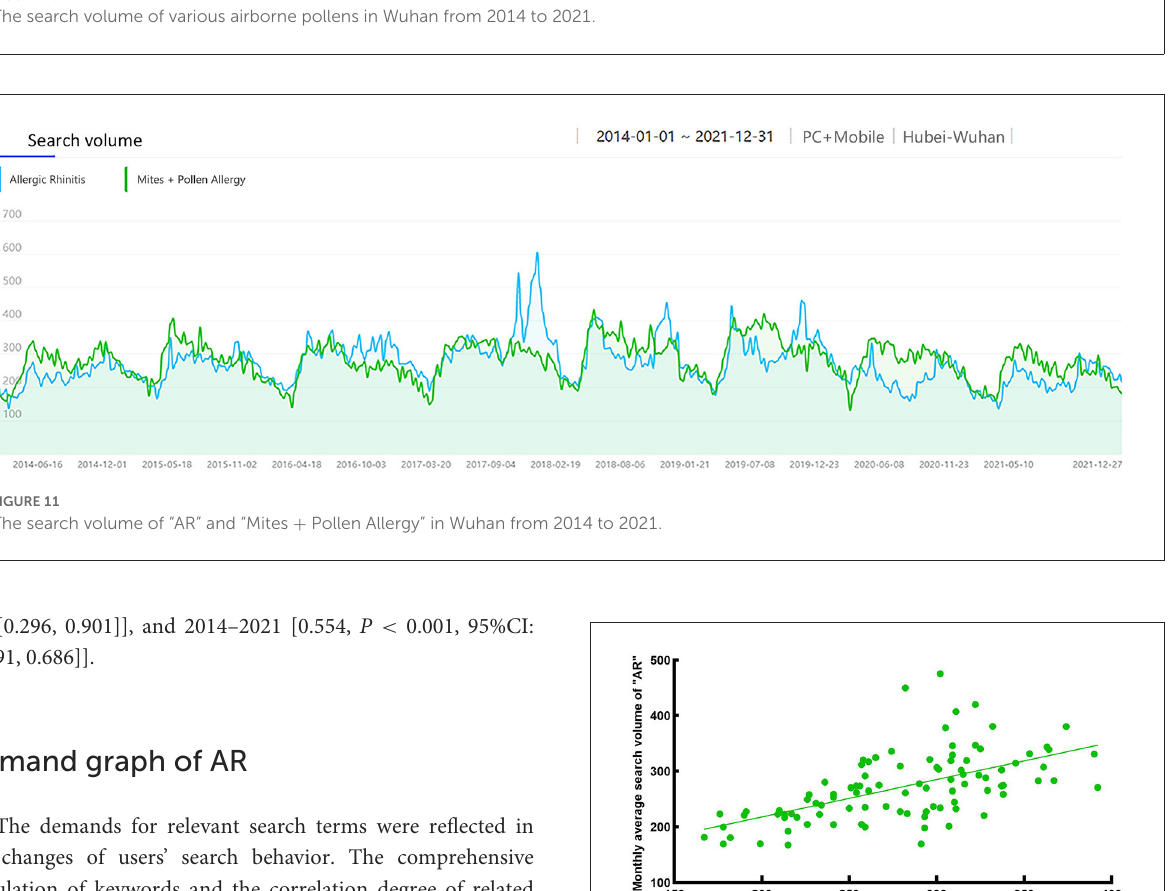
FIGURE12 Search volume correlation analysis of “AR” and “Mites + Pollen Allergy” in Wuhan from 2014 to 2021.